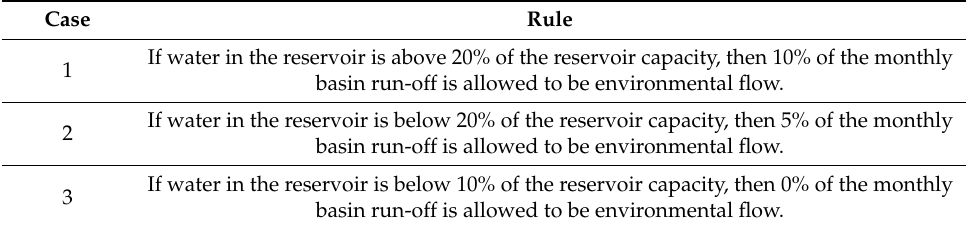
Table 2. Policy rules to foster ecosystem services and the biodiversity of ecosystems downstream of Sardinian